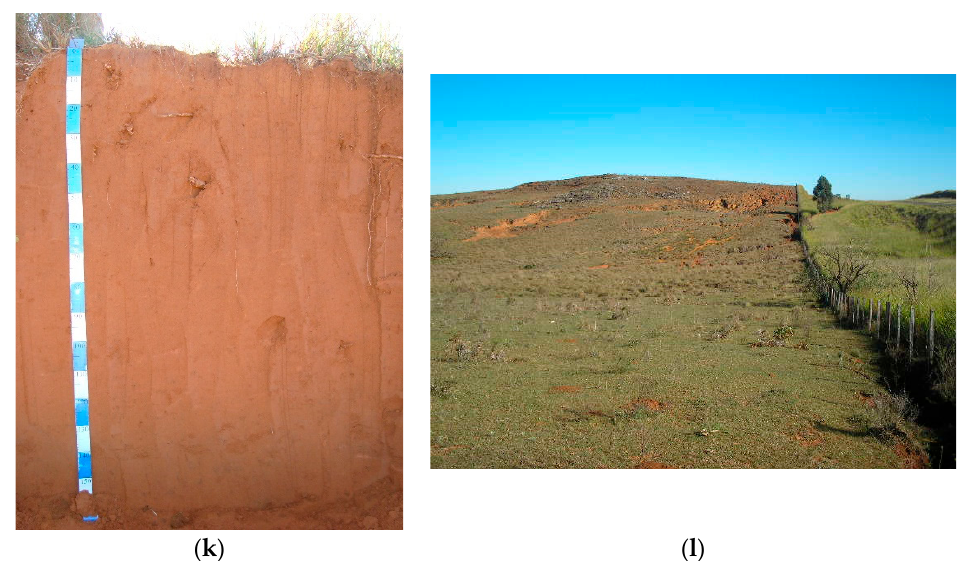
Figure 3. Quartzipsamments profiles NQ1 and NQ2 from Quaraí city (respectively, ( a , c )), NQ3 and NQ4 from Manoel Viana city (respectively, ( e , g )), NQ5 and NQ6 from São Francisco de Assis city (respectively, ( i , k )), Rio Grande do Sul State, and their respective landscape (respectively, ( b , d , f , h , j , l )). Each color on the measuring tape represents 10 cm in the profile pictures. Source: pictures taken by F.d.A. Pedron and L.E.A.S. Suzuki.